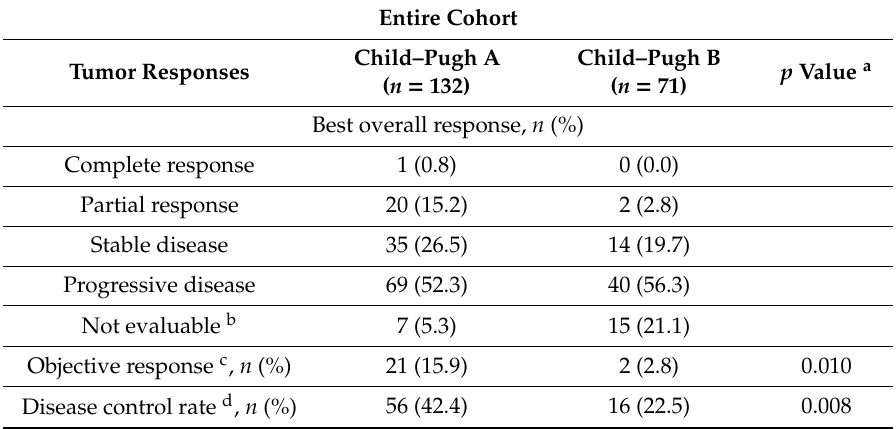
Table 3. Tumor responses in the study population according to modified Response Evaluation Criteria in Solid Tumors (mRECIST)